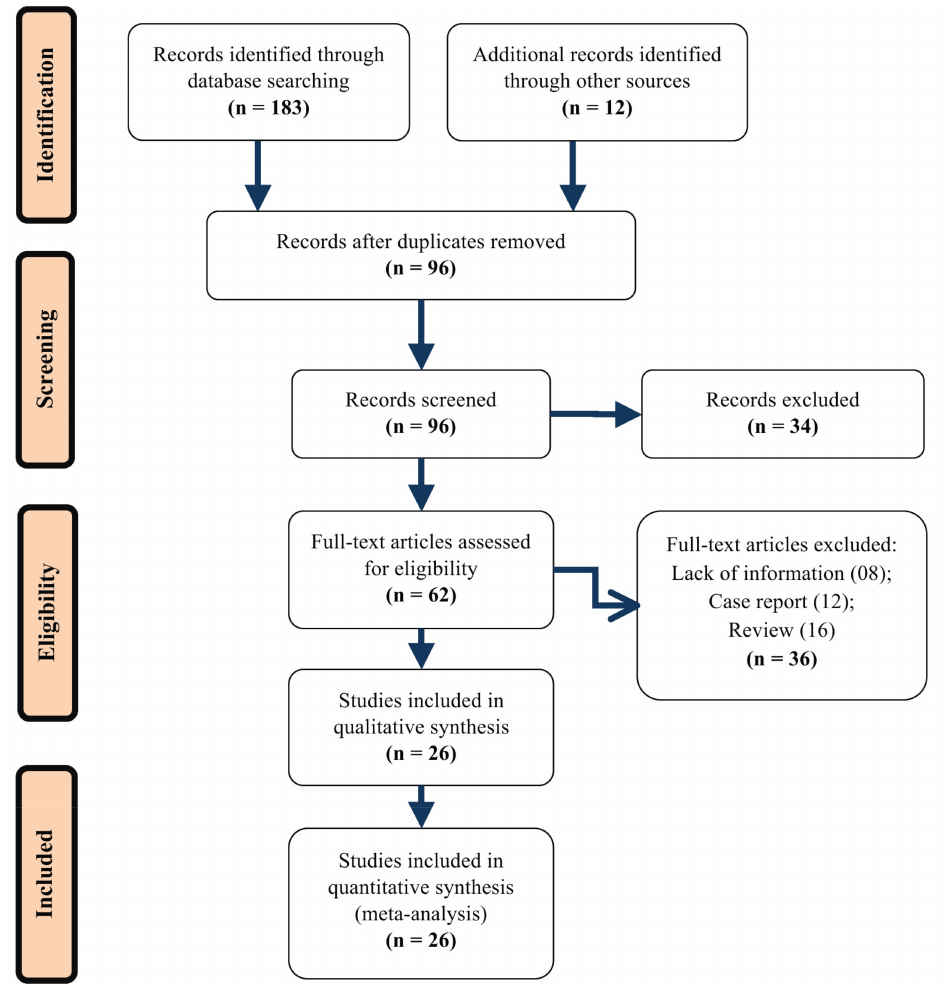
Figure 1. Flow diagram of literature search for including studies in